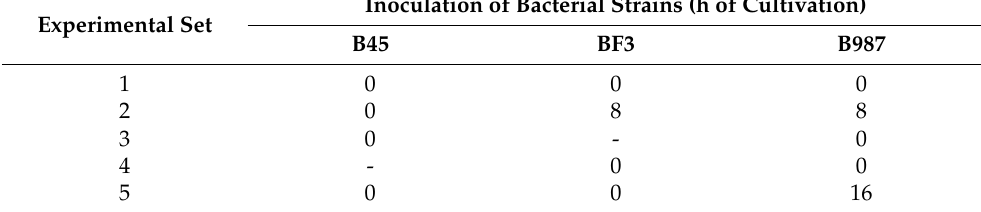
Table 1. Development of consortium for multienzyme preparation under Solid State fermentation of Sugarcane bagasse. Strain B45 of Bacillus thuringiensis , B. velezensis BF3 and B. amyloliqufaciens B987 were inoculated together (experiment 1) or with a different inoculation pattern and enzyme production in cell free culture supernatant was noted. (Inoculum of the strains was maintained at 2.8–3.2 × 10 8 cells per mL). Inoculation of Bacterial Strains (h of Cultivation) Experimental Set B45 BF3